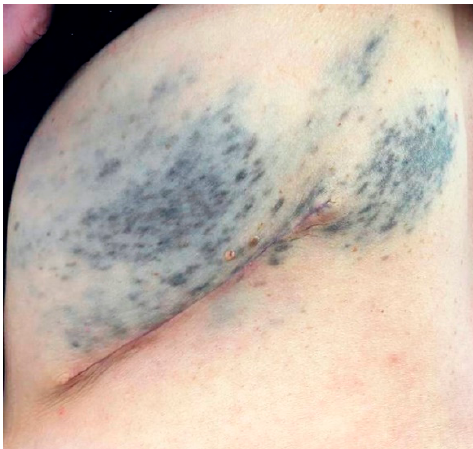
Figure 1. Thoracic melanosis with a characteristic metameric distribution.